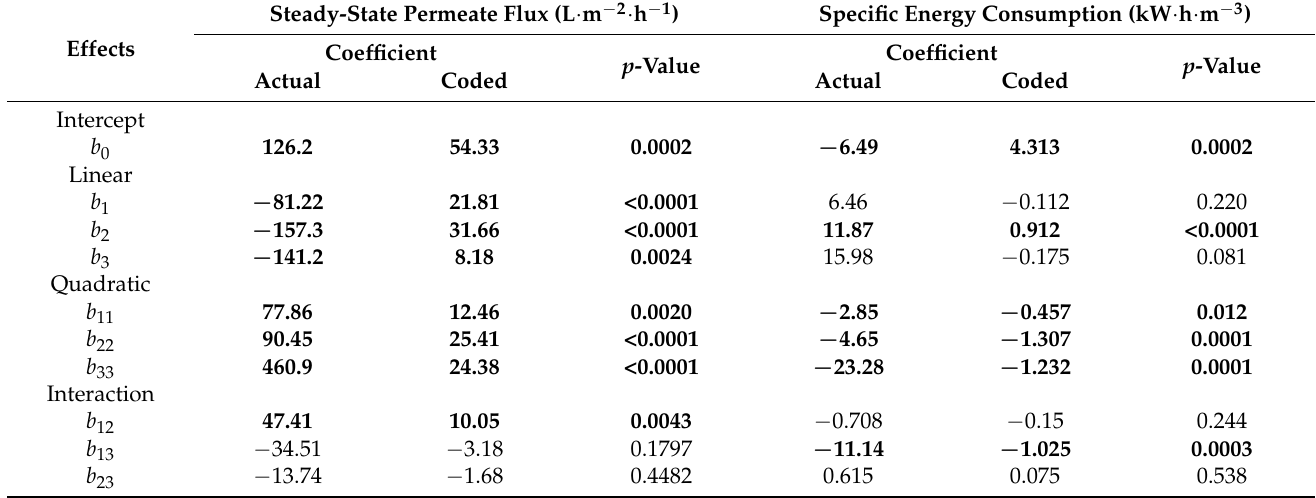
Table 2. Coefficients of regression models for steady-state permeate flux and specific energy con- sumption for broth SMGS microfiltration experiments.